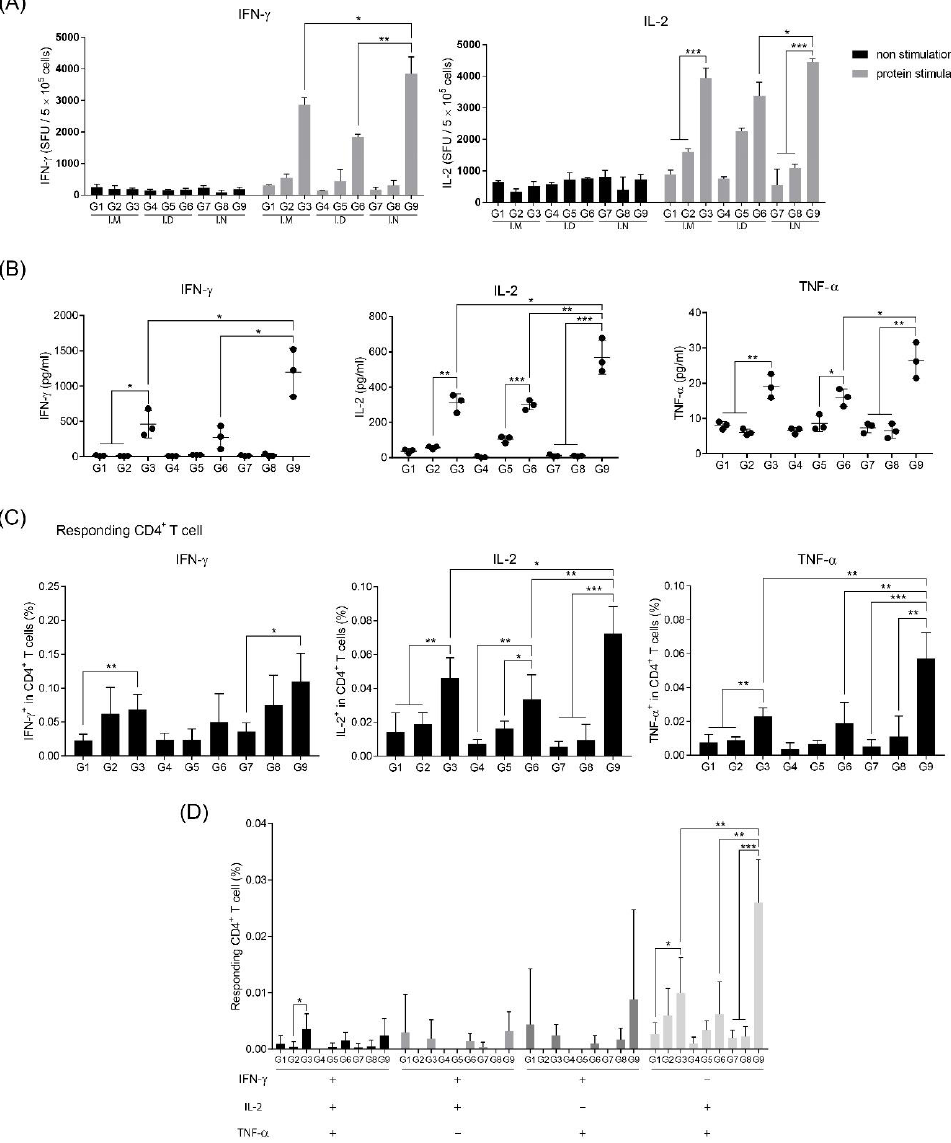
Figure 3. Analysis of T-cell activation after immunization with the RNA adjuvant and MERS S protein vaccine. ( A ) The population of MERS S protein-specific cells secreting interferon- γ (IFN- γ ) and interleukin-2 (IL-2) were quantified by using ELISPOT assay, after treatment with MERS S protein in cultured splenocytes from immunized mice. ( B ) Cytokine levels in splenocyte supernatants stimulated with MERS S protein from immunized mice were measured, using ELISA. ( C ) IFN- γ , IL-2, and tumor necrosis factor α (TNF- α )-producing CD4 + T-cells in splenocytes were counted by flow cytometry. ( D ) IFN- γ , IL-2, and TNF- α producing polyfunctional CD4 + T-cells in splenocytes were analyzed by flow cytometry. *, p < 0.05; **, p < 0.005; ***, p < 0.001. 3.4. RNA Adjuvant Induces Antigen-Presenting Cells, Especially Dendritic Cells As pathogens invade, APCs — particularly professional APCs such as macrophages and dendritic cells (DCs) — take up pathogens and then present the pathogen epitope to immune cells, such as T-cells in spleen or lymph nodes via major histocompatibility complex molecules, causing an